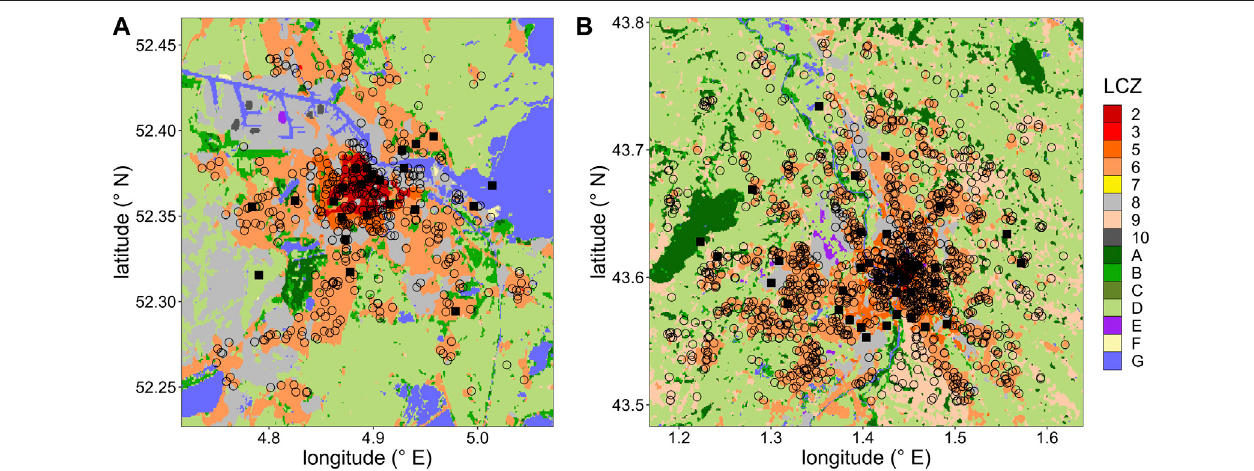
FIGURE1 | Study regions (A) Amsterdam and (B) Toulousewiththe location ofweatherstations and Local Climate Zones LCZ. Citizen weather stations (raw data availability) are displayed as black circles, professionally-operated weather stations as black squares. A more detailed description of the LCZ scheme can be found in Stewart & Oke (2012).